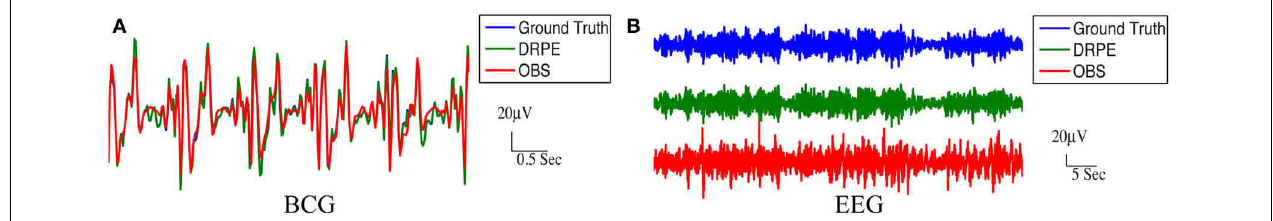
FIGURE 8 | Comparison of the reconstruction results from DRPE and OBS. Ground truth, DRPE and OBS results are shown in each panel. The DRPE method yields only 6.685% and 16.45% relative errors for the BCG and EEG reconstruction, while the OBS generates 47.50% and